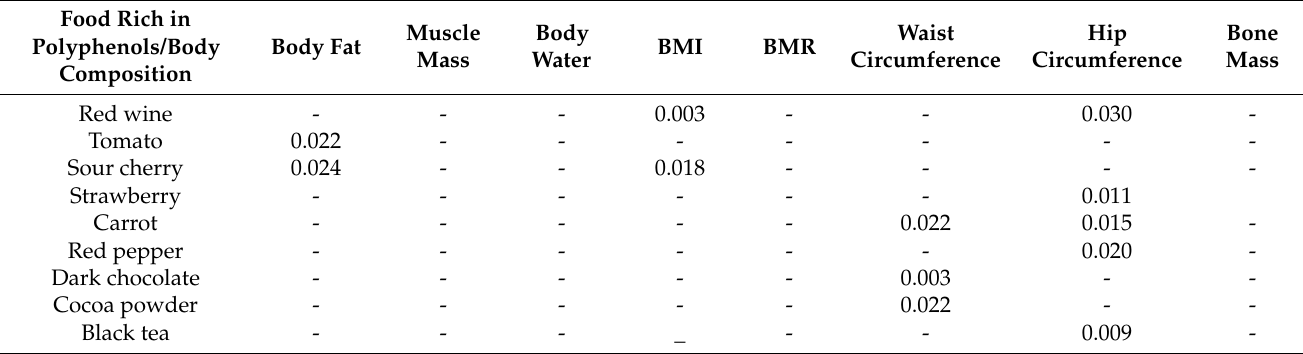
Table 4. Association among the consumption foods rich in polyphenols with anthropometric indices. Food Rich